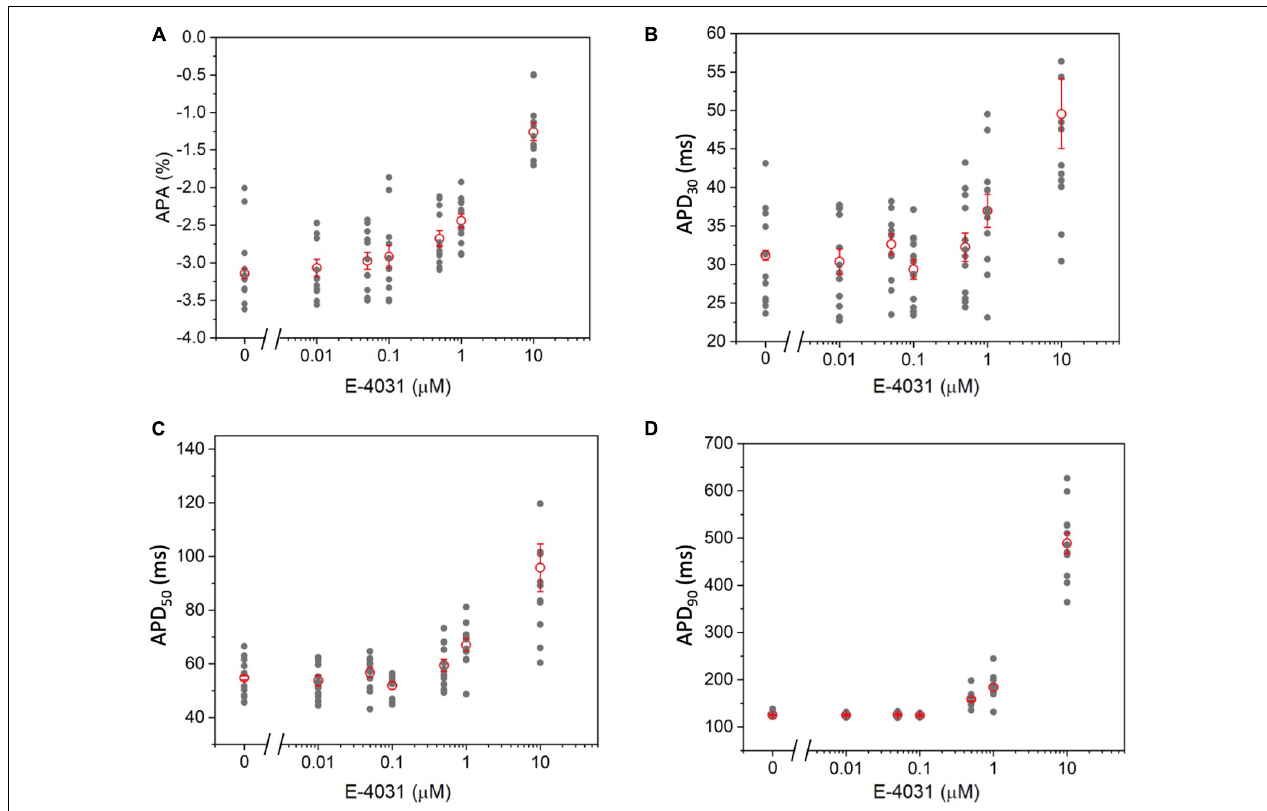
FIGURE 9 | Dose–dependent effects of E-4031 on AP kinetics. (A) APA, (B) APD 30 , (C) APD 50 , and (D) APD 90 as a function of E-4031